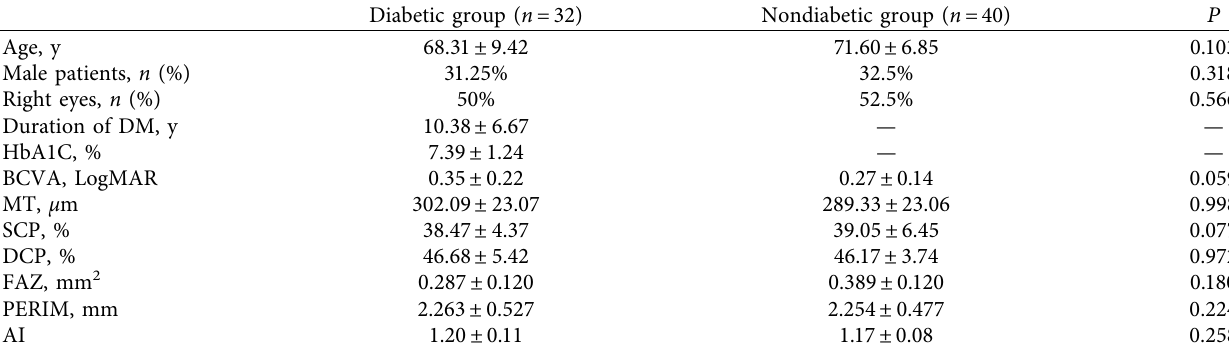
Table 1: Baseline characteristics of the two groups.